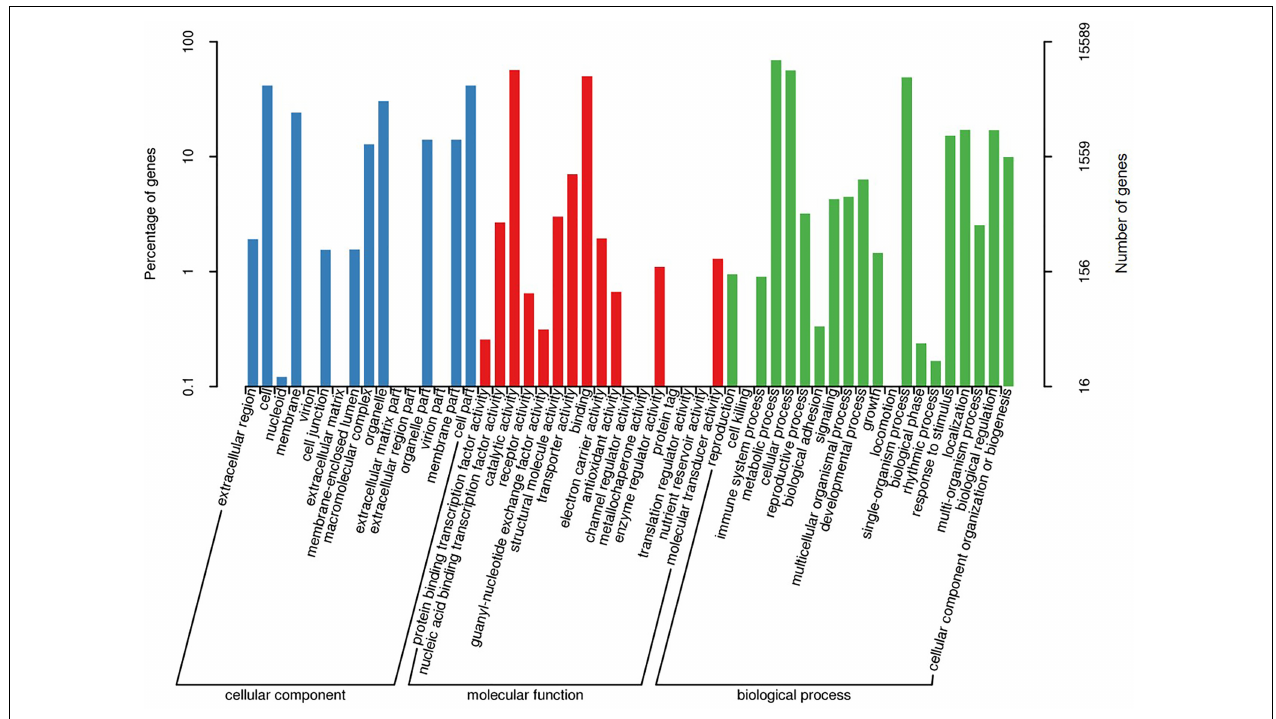
FIGURE 4 | Gene ontology (GO) classification of assembled